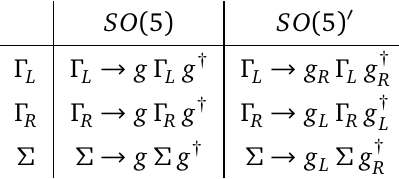
Table 1: Transformation properties of the spurions Γ Goldstone matrix Σ under the global symmetry group, SO ( 5 ) , and maximal symme- try, SO ( 5 ) (cid:48) . The Σ transformation under SO ( 5 ) (cid:48) should be regarded as spurious, see discussion around Eq.